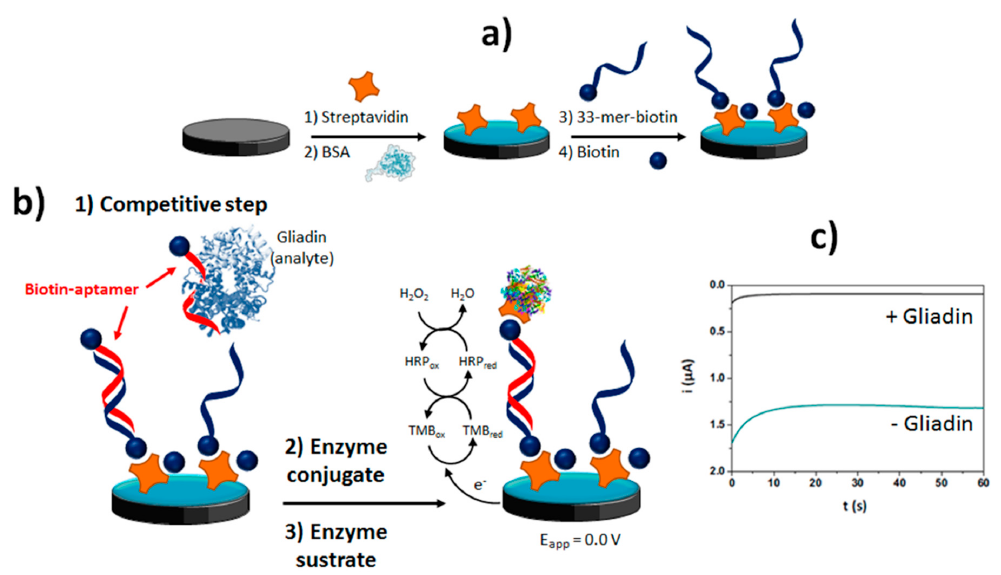
Figure 6. Competitive aptasensing method developed for the electrochemical determination of gluten: sensor fabrication ( a ) competitive assay ( b ) chronoamperometric transduction in the presence of H 2 O 2 / TMB ( c ) Figure drawn based on [16].